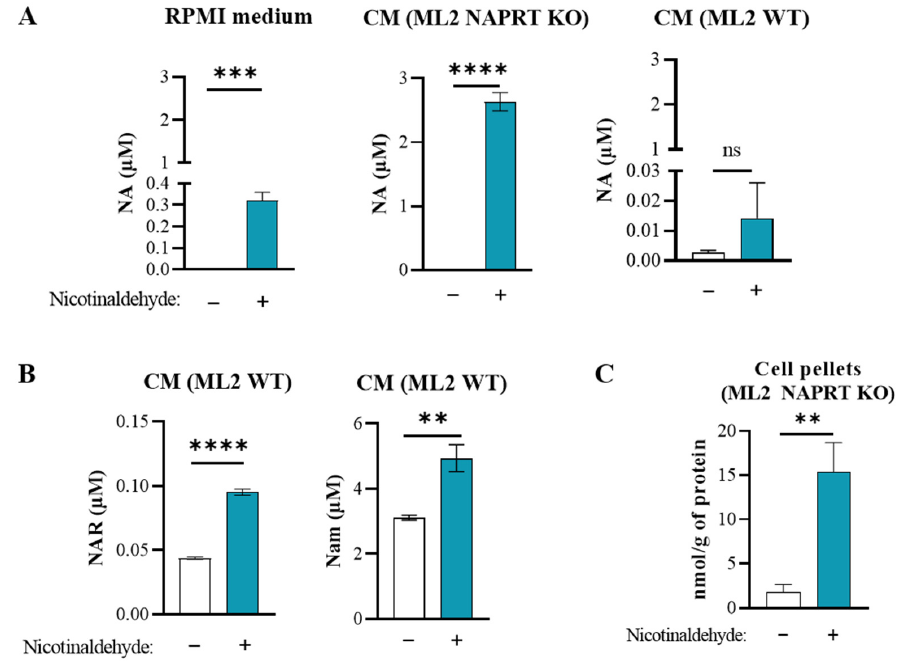
Figure 4. Nicotinaldehyde supplementation modifies NAD-related metabolite levels in the culture medium and within cells. NAD metabolites were quantified by LC-MS/MS in cells and conditioned media (CM) after 96 h of incubation at 37 ◦ C. ( A) NA concentration in the culture medium supple- mented without ( − ) or with (+) nicotinaldehyde (10 µ M), in absence of cells or in presence of ML2 WT or ML2 NAPRT KO cells, after 96 h of incubation at 37 ◦ C. ( B ) NAM and NAR concentrations in the conditioned media of ML2 WT cells without or with nicotinaldehyde supplementation (10 µ M). ( C ) Intracellular concentration of NA normalized to protein concentration in ML2 NAPRT KO cells cultured in medium supplemented without or with nicotinaldehyde (10 µ M). n = 3 error bars = SD, ns = non-significant. ** p < 0.01, *** p < 0.001, **** p < 0.0001 (vs. not supplemented medium if not specified otherwise).